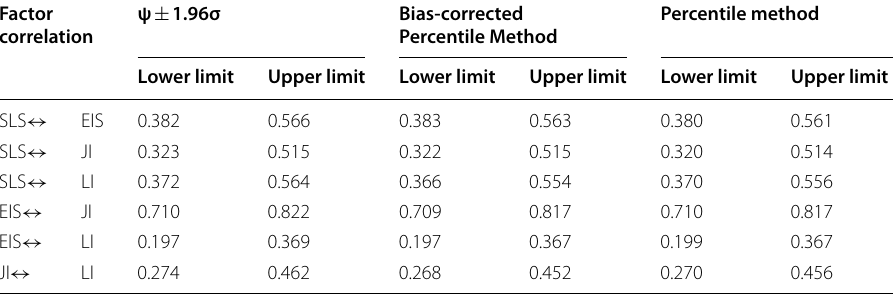
Table 4 CFA results: discriminant validity Factor correlation